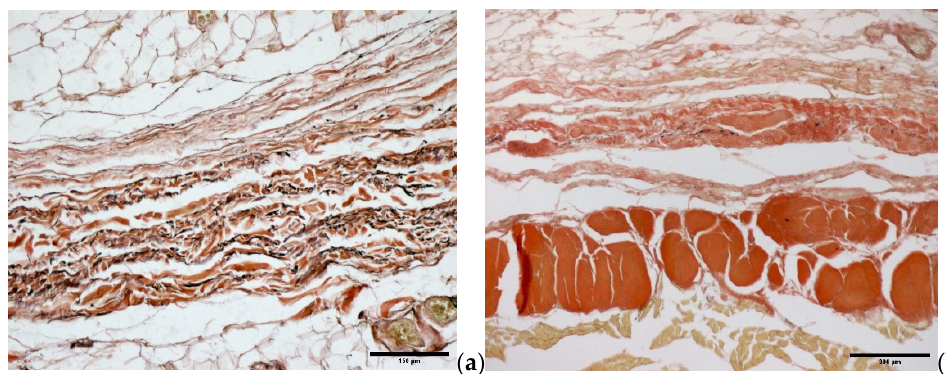
Figure 3. Histological images (Weigert Van Gieson staining that highlights the elastic and collagen fibers): ( a ) superficial fascia, ( b ) deep/muscular fascia.